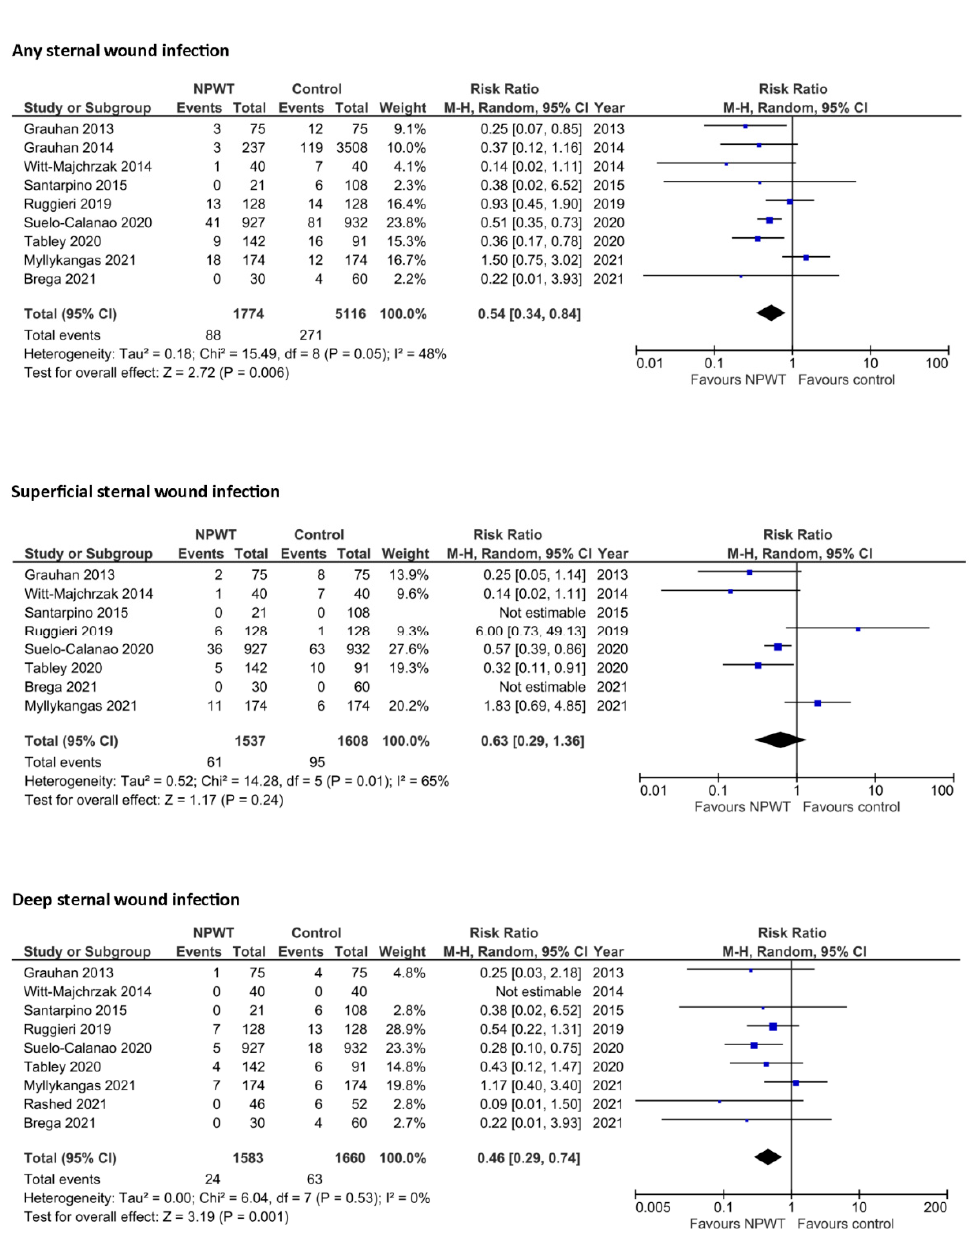
4 of 8 Table 2. Pooled characteristics of patients of the included studies. Variables